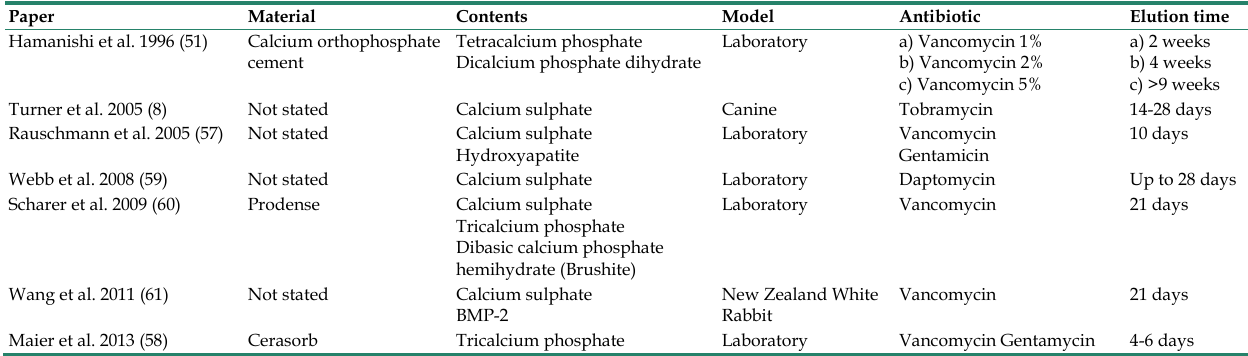
Table 3. Papers investigating in vitro antibiotic elution times for ceramic local antibiotic carriers.